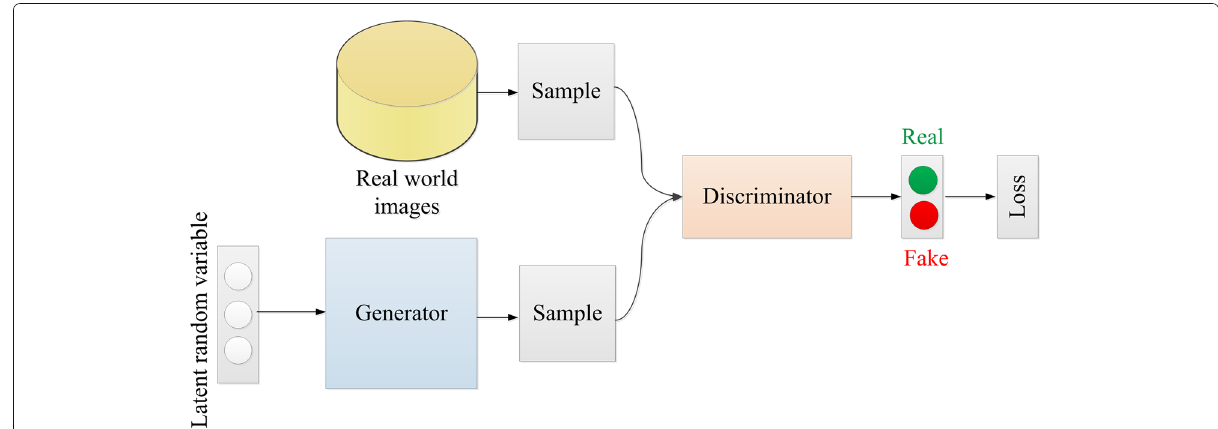
Fig. 1 Structure of generative adversarial network